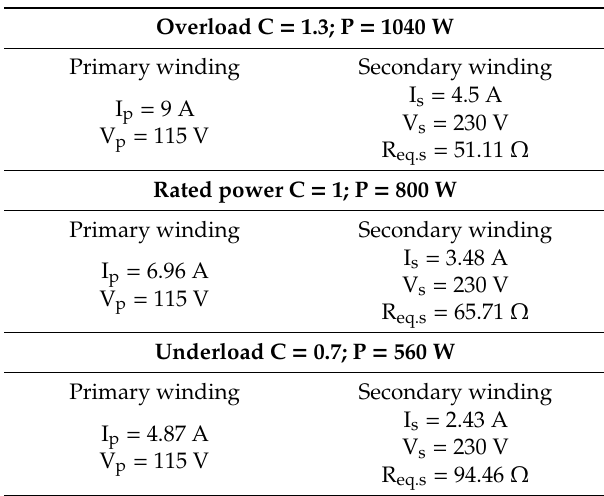
Table 3. Circuit parameters during the load tests.